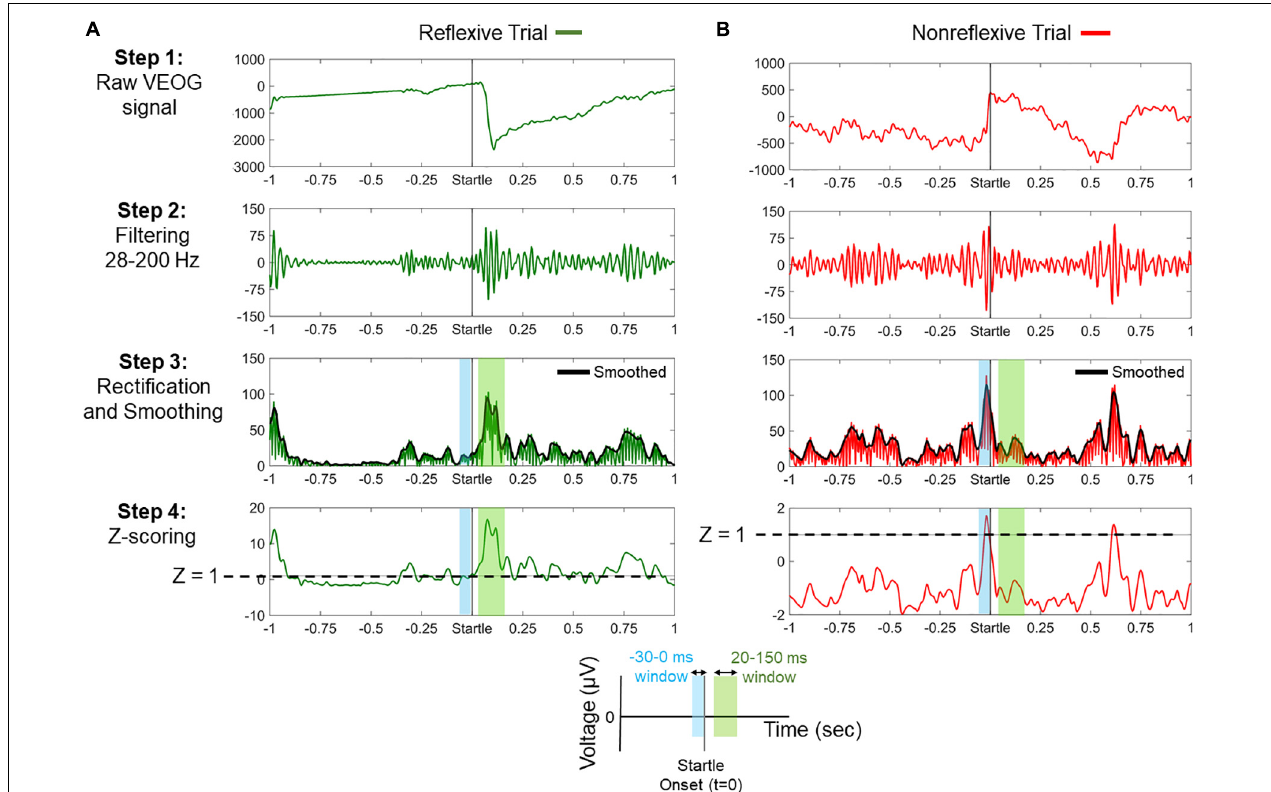
FIGURE 2 | Processing steps for the classification between reflexive and nonreflexive trials based on the vertical electro-oculogram (VEOG) signal. (A) An example of a reflexive trial showing a strong blink immediately after startle onset. In step 4, it is shown that the poststartle Z score (within 20–150 ms) exceeds the threshold of 1 (dashed line), meaning that the blink is at least 1 SD above the prestartle –30- to 0-ms period. (B) An example of a nonreflexive trial showing the presence of a strong blink immediately before startle onset and a non–startle-related blink approximately 600 ms. In step 4, negative values of the poststartle Z scores (within 20–150 ms) indicate that the prestartle blink was dominant. Color-shaded areas highlight the prestartle (blue) and poststartle (green) windows of interest, as indicated by the legend at the bottom.